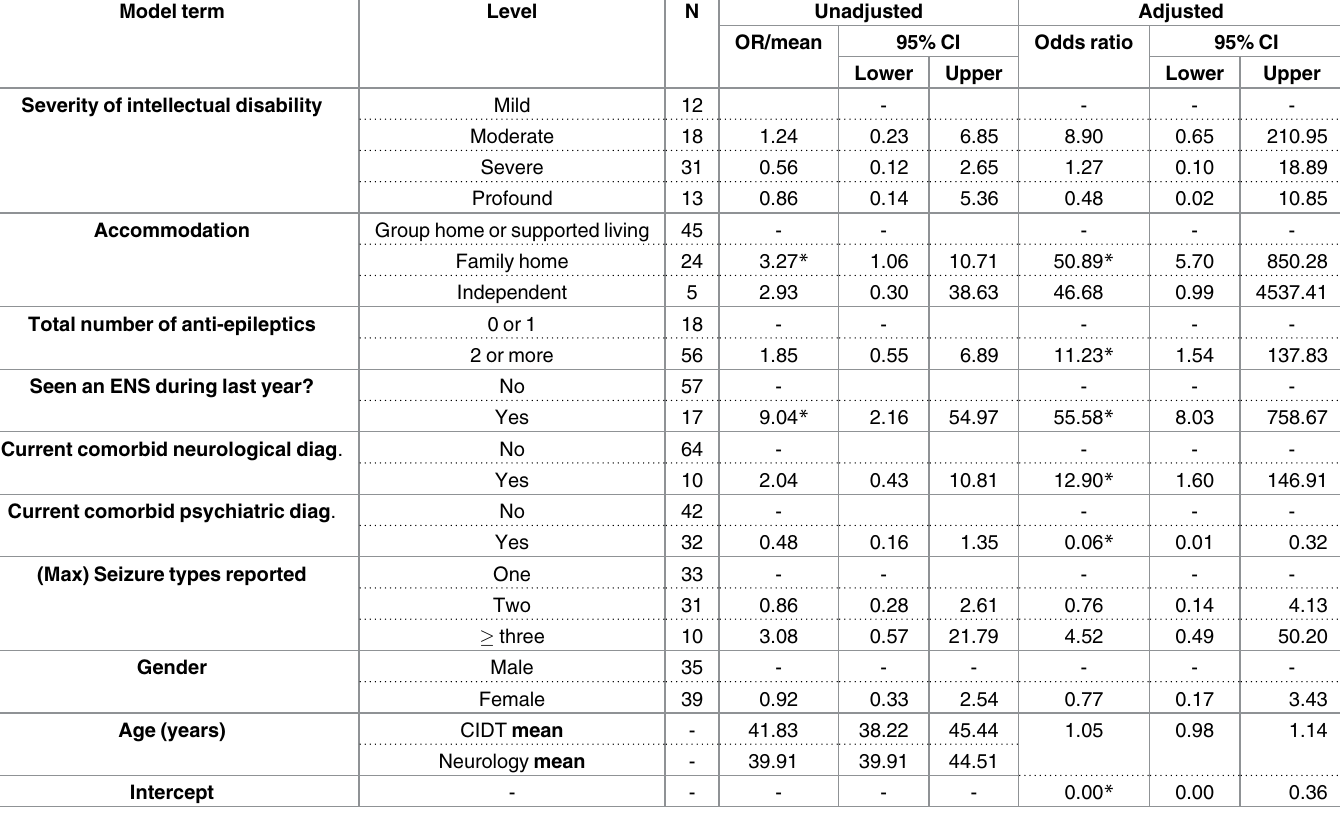
Table 2. Unadjusted and adjusted comparisons in casemix variables (along with gender and age) between CIDT (referencelevel) and Neurology. Unadjusted univariate comparisons made using Fisher’s exact test or two sample t-test (for age). Adjusted comparisons are estimated from a logistic model (with servicetype as response variable) including all the variables listed in the Table . OR = odds ratio. ENS = epilepsynurse specialist. diag = diagnosis. Model term